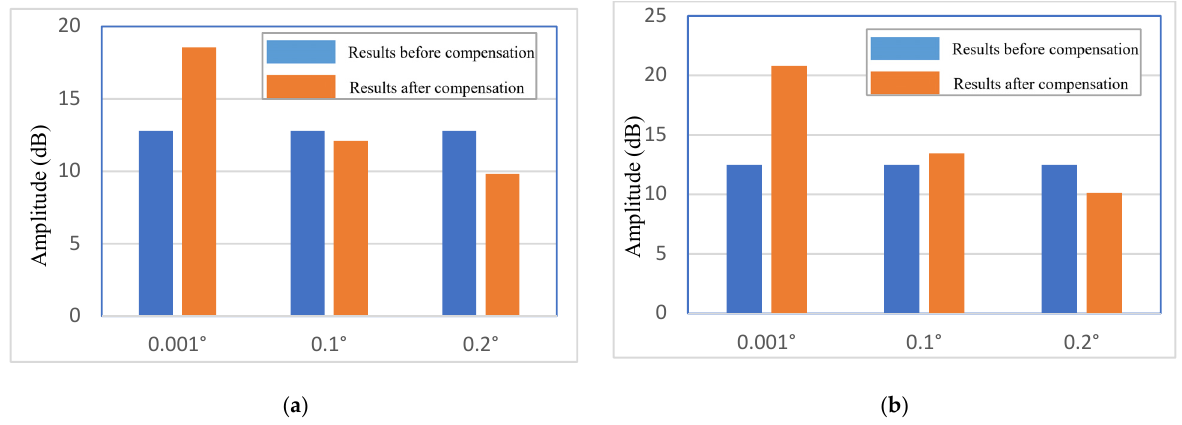
Figure 23. Statistical table of the SNR for the two targets before and after motion compensation under different heading measurement errors: ( a ) target 1, ( b ) target 2.